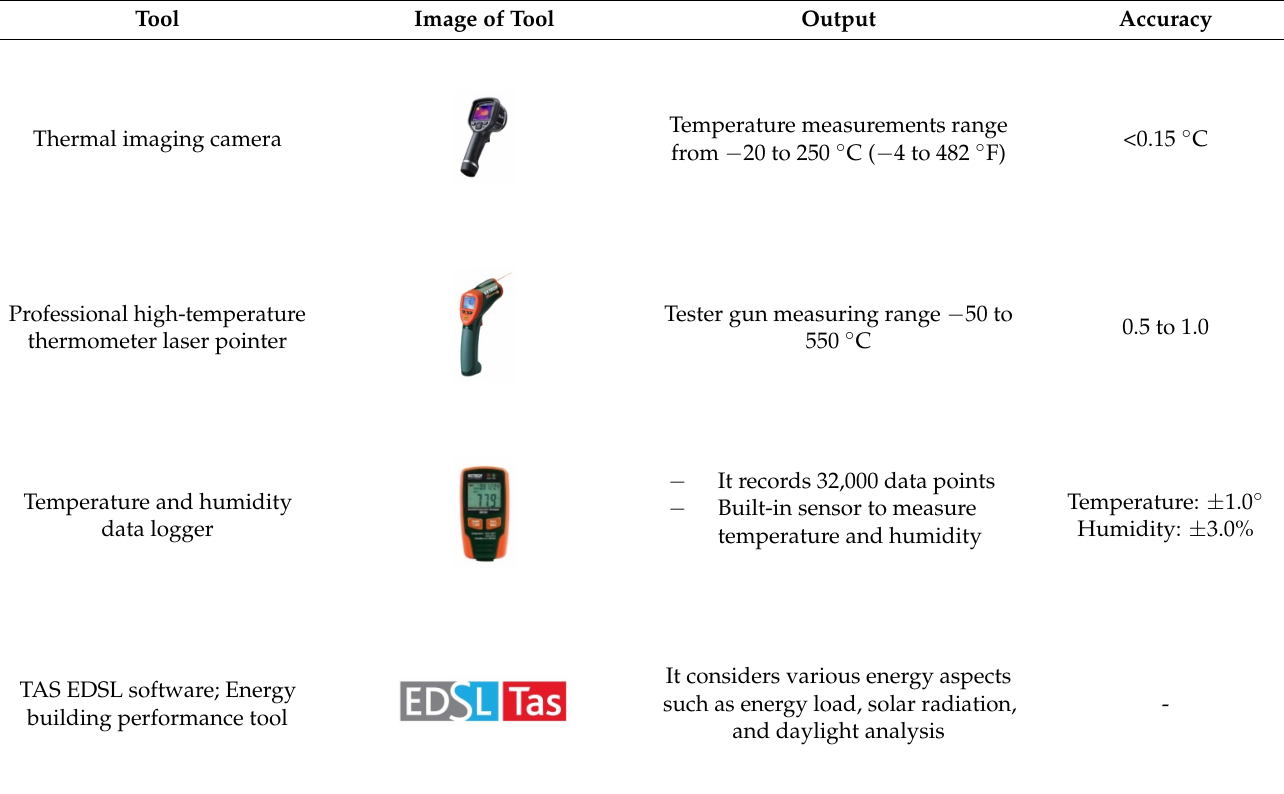
Table 2. Tools and equipment used in research